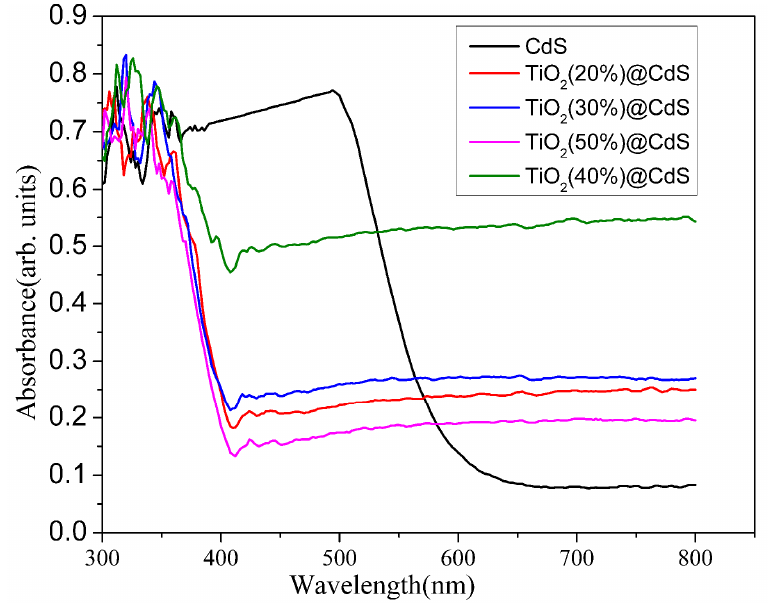
Figure 5. UV-visible diffuse reflectance spectra of TiO 2 nanorod–CdS nanoparticle composites and the CdS